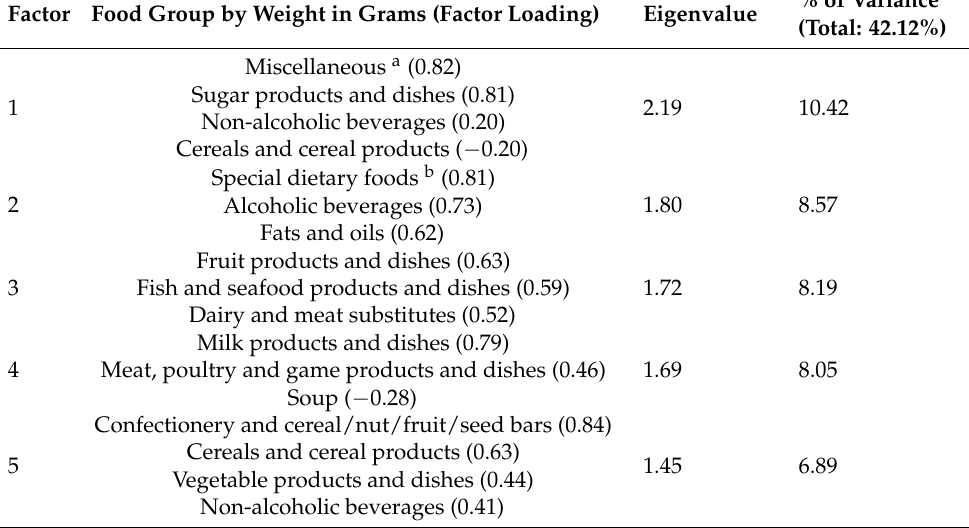
Table 5. Factor loadings for food groups that loaded highly (|>0.2|) in varimax rotated principal